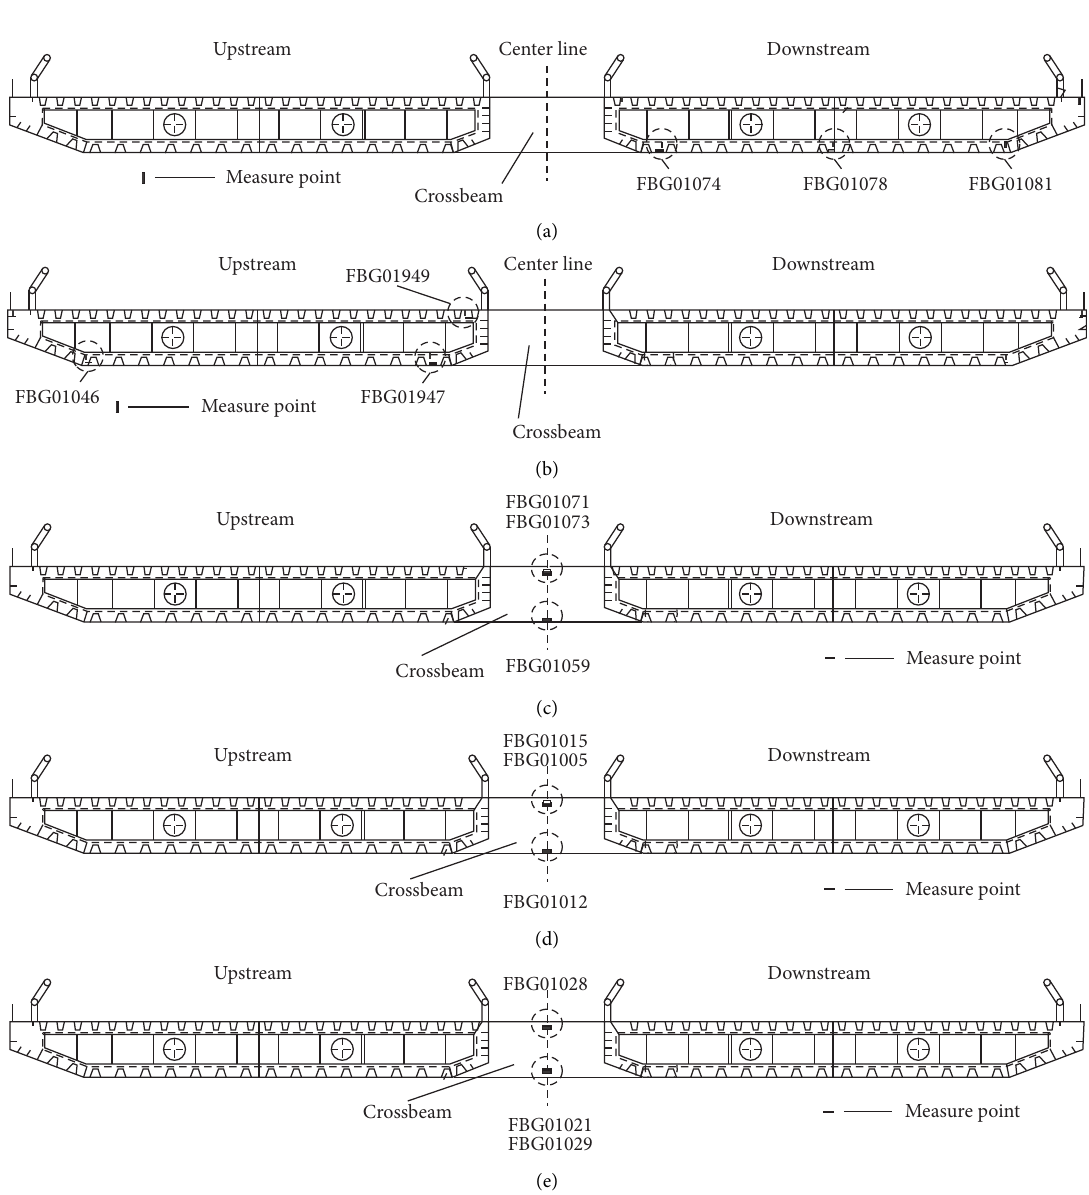
Figure 4: Stress sensors of the five monitoring cross sections. (a) Section A. (b) Section B. (c) Section C. (d) Section D. (e) Section